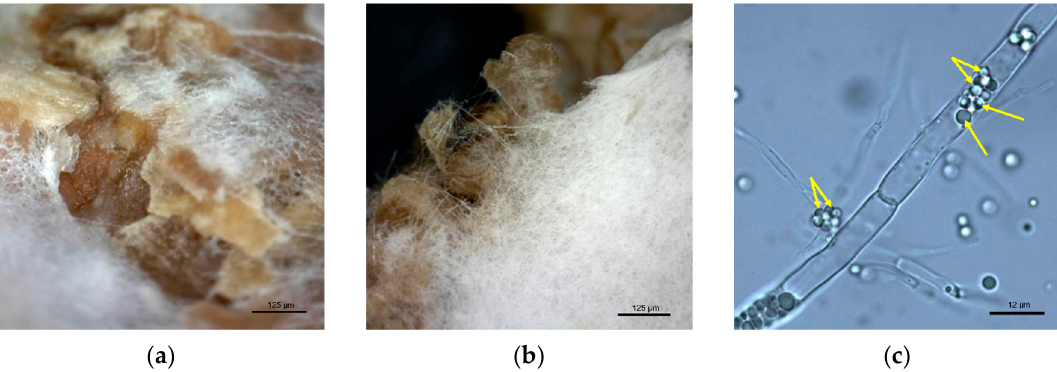
Figure 1. Microscopic images of M. alpina hyphae covering wheat bran ( a ), wheat bran with animal fat during solid-state fermentation ( b ) and lipid droplets accumulated inside M. alpina hyphae ( c ).